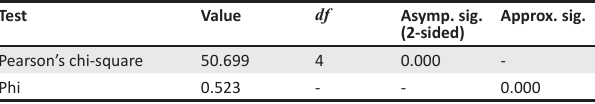
Approx. sig. (2-sided)